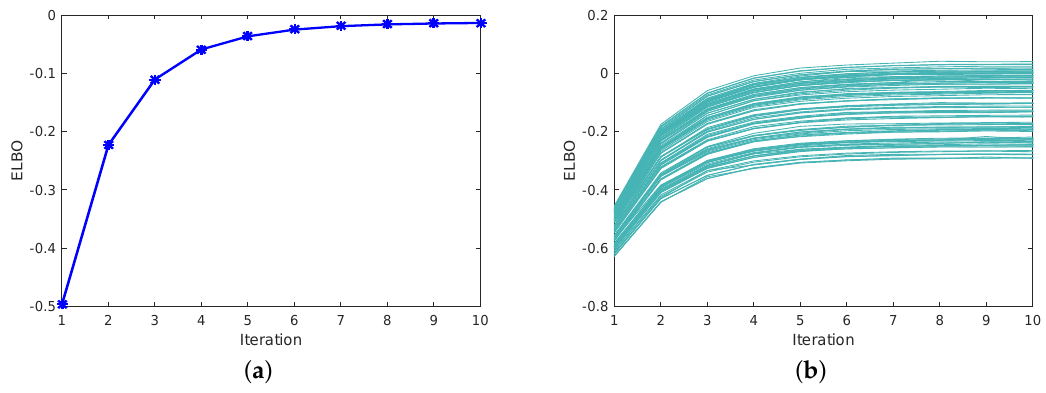
Figure 4. The curve in ( a ) is the ELBO of the second scan. The curves in ( b ) are the ELBO of all